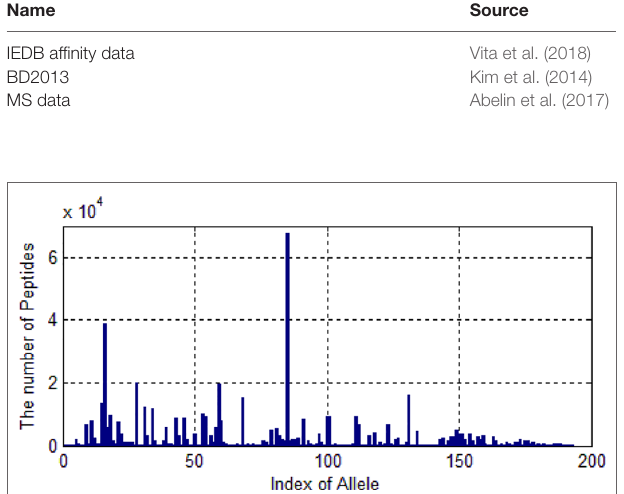
FIgURe 5 | The distribution of the number of peptides of 193 alleles.